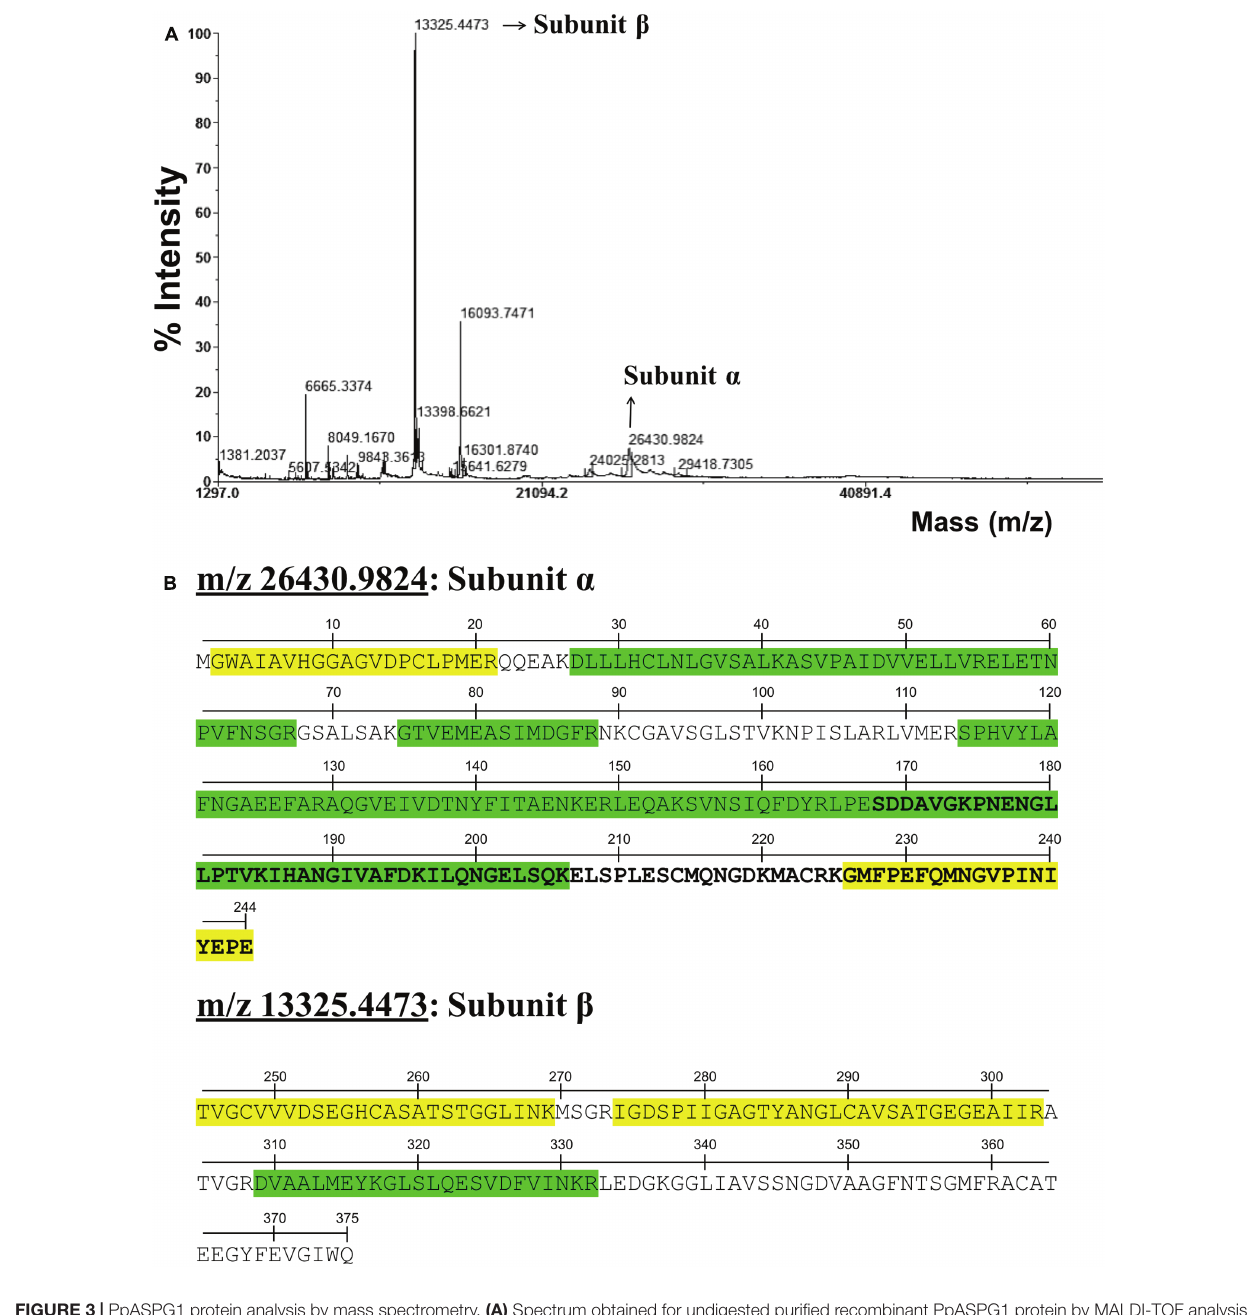
FIGURE 3 | PpASPG1 protein analysis by mass spectrometry. (A) Spectrum obtained for undigested purified recombinant PpASPG1 protein by MALDI-TOF analysis in linear mode. (B) Identification of the peptides resulting from in gel digestion of the spots corresponding to m/z 26430.9824 and 13325.4473, marked upon the PpASPG1 protein sequence separated by its subunits. Green shaded letters: peptides identified by MALDI-TOF; yellow shaded letters: peptides that were fragmented and their sequences were confirmed by MS/MS; letters in bold: variable sequence region not conserved between homologous ASPG.